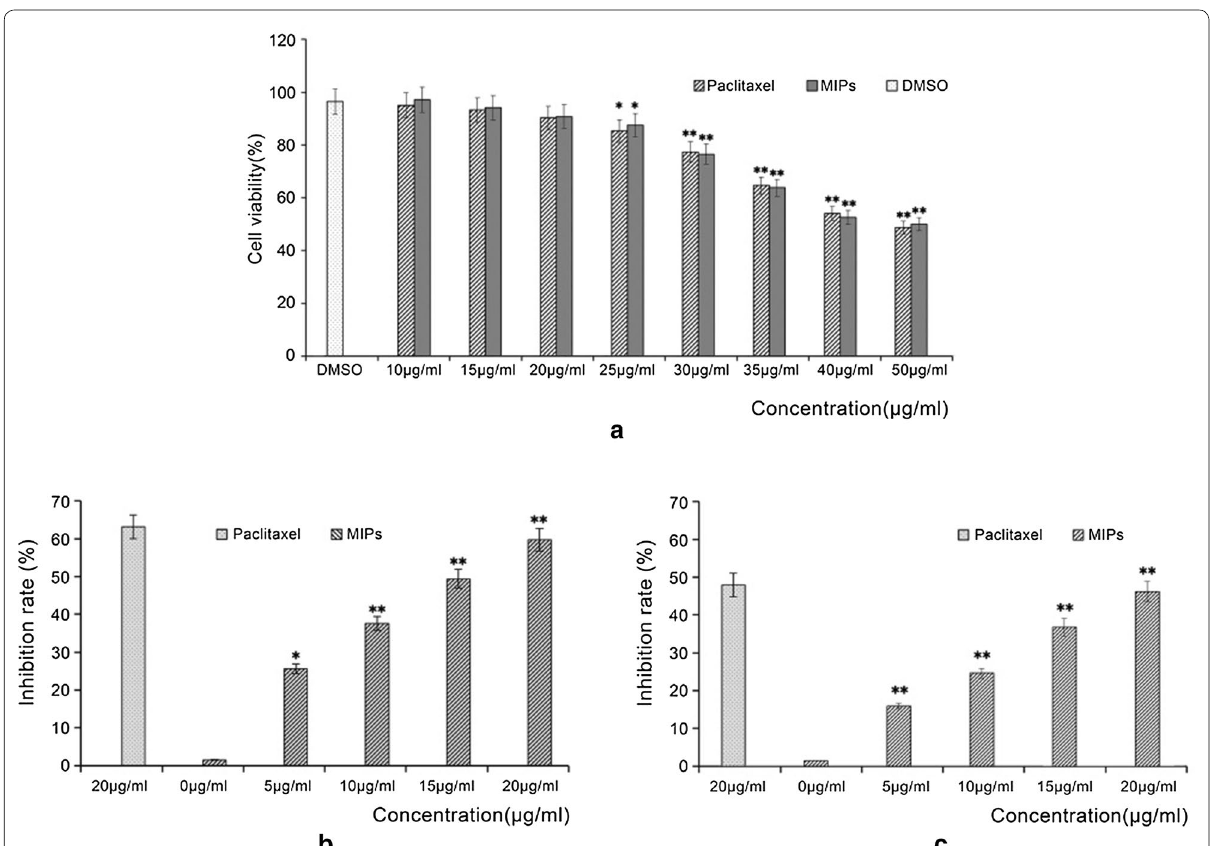
Fig. 3 Antitumor activity of paclitaxel. a Cytotoxicity of paclitaxel on 293T cells; b inhibitory activity of paclitaxel on MCF-7 cells; c inhibitory activity of paclitaxel on Hela cells. *p < 0.05, **p < 0.01 versus non-treatment with